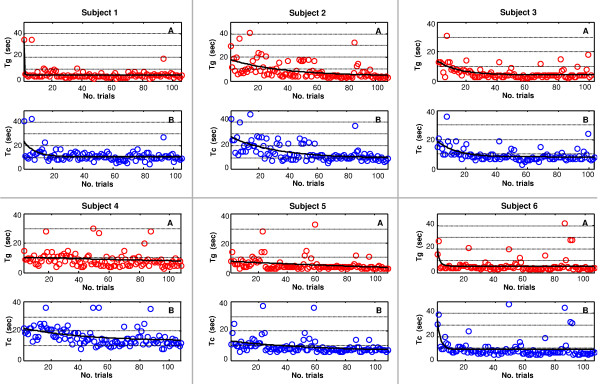
Object-grasp and task-completion time trends throughout days for each subjects in G2. (A) Object-grasp (Tg) and (B) task-completion (Tc) times for power, precision and lateral grasps throughout trials. Data are sorted following their temporal execution order (day 1: set 1 and 2, day 2: set 1 and 2, day 3: set 1 and 2). Each dataset is fitted with a decreasing exponential function (black curve) demonstrating the improvement in performance.